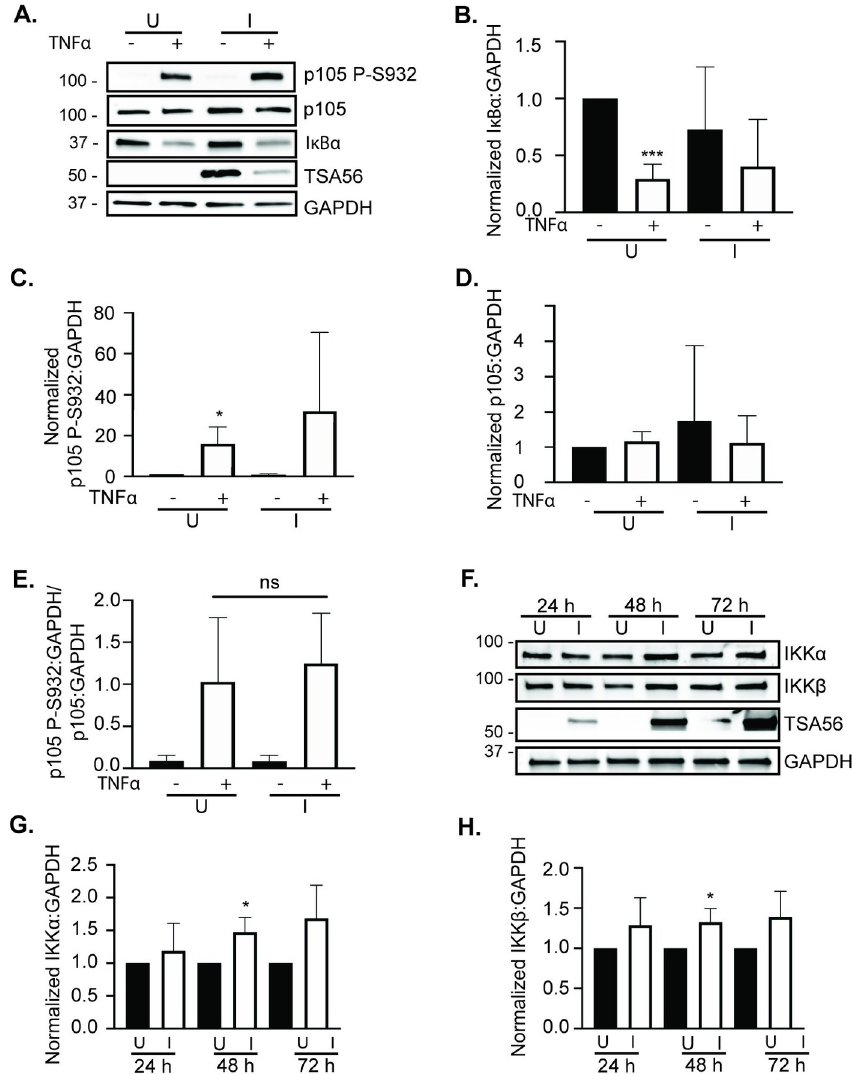
Fig 5. O . tsutsugamushi does not inhibit TNF α -stimulated phosphorylation of p105 Ser932 or reduce IKK α or IKK β levels. (A to E) HeLa cells were mock infected (U) or infected with O . tsutsugamushi at a MOI of 10 (I). At 72 h, the cells were treated with calyculin A and TNF α (+) or vehicle control (-) for 5 min. (A) Whole cell lysates were collected and analyzed by Western blot using antibodies targeting p105, p105 phosphorylated Ser932 (P-S932), I κ B α , TSA56, and GAPDH. Mean normalized ratios + SD of I κ B α :GAPDH(B), p105 P-S932:GAPDH (C), p105:GAPDH (D), and P-S932:GAPDH/p105:GAPDH (E) from three separate experiments were calculated using densitometry. (F to H) Whole cell lysates of U and I HeLa cells recovered at 24, 48, and 72 h post-infection were subjected to Western blot analyses using the indicated antibodies (F). (G and H) Mean normalized ratios + SD of IKK α :GAPDH (G) or IKK β : GAPDH (H) from three separate experiments in (F) were calculated using densitometry. Data are indicative of three independent experiments that yielded similar results. Statistically significant ( � , P < 0.05; ��� , P < 0.001) values are